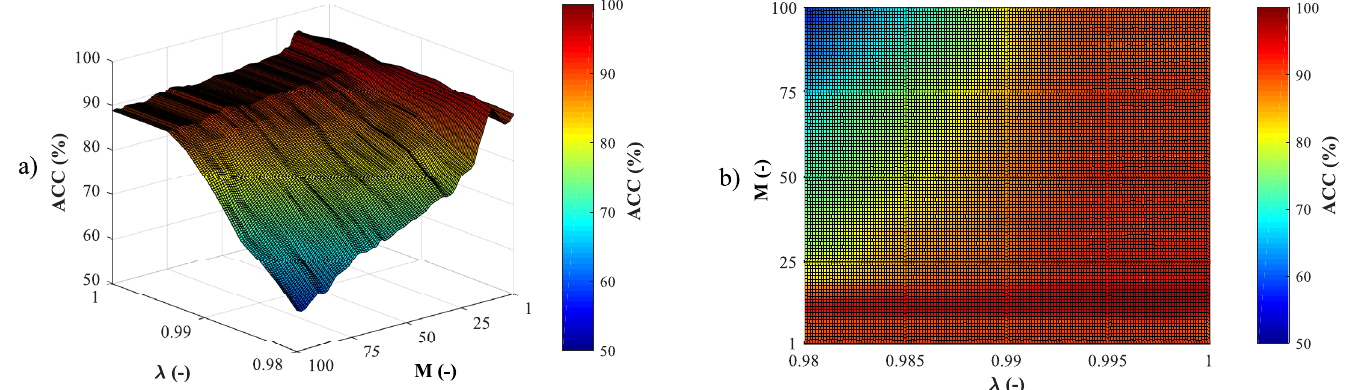
Fig 18. Illustration of the influence of parameter settings (filter order M and forgetting factor λ ) in the RLS method on the resulting quality of the extracted signal a) using the front view 3D graph and b) top-down view.